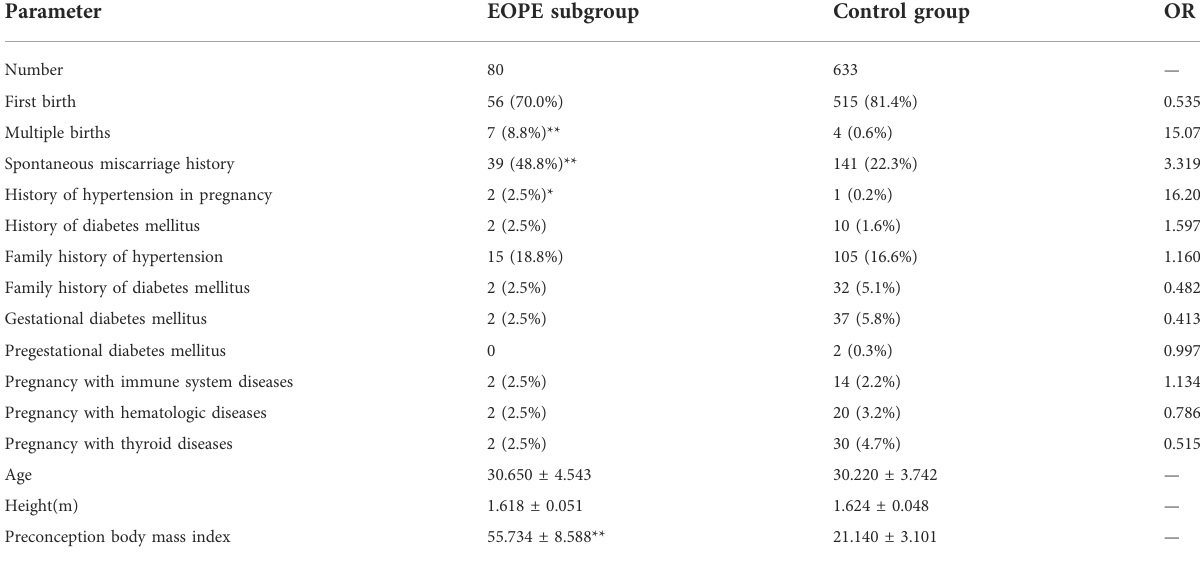
TABLE 2 Analysis of factors that do not change with gestational age in EOPE subgroup and control.